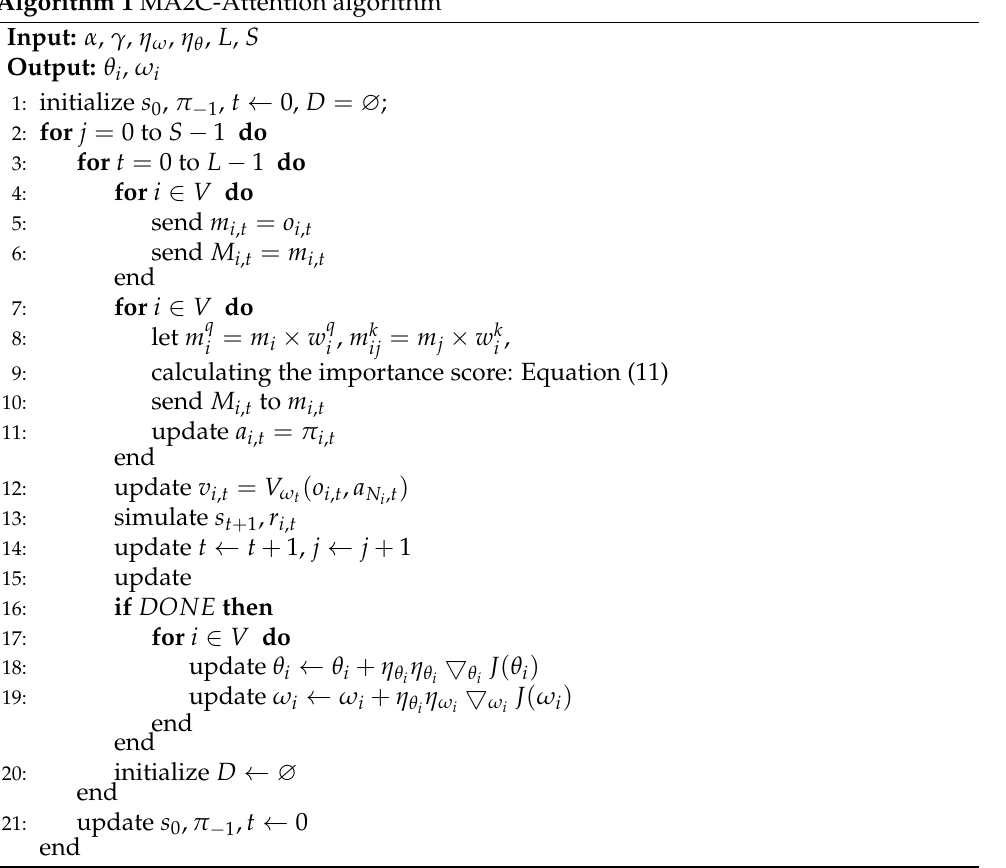
Algorithm 1 MA2C-Attention